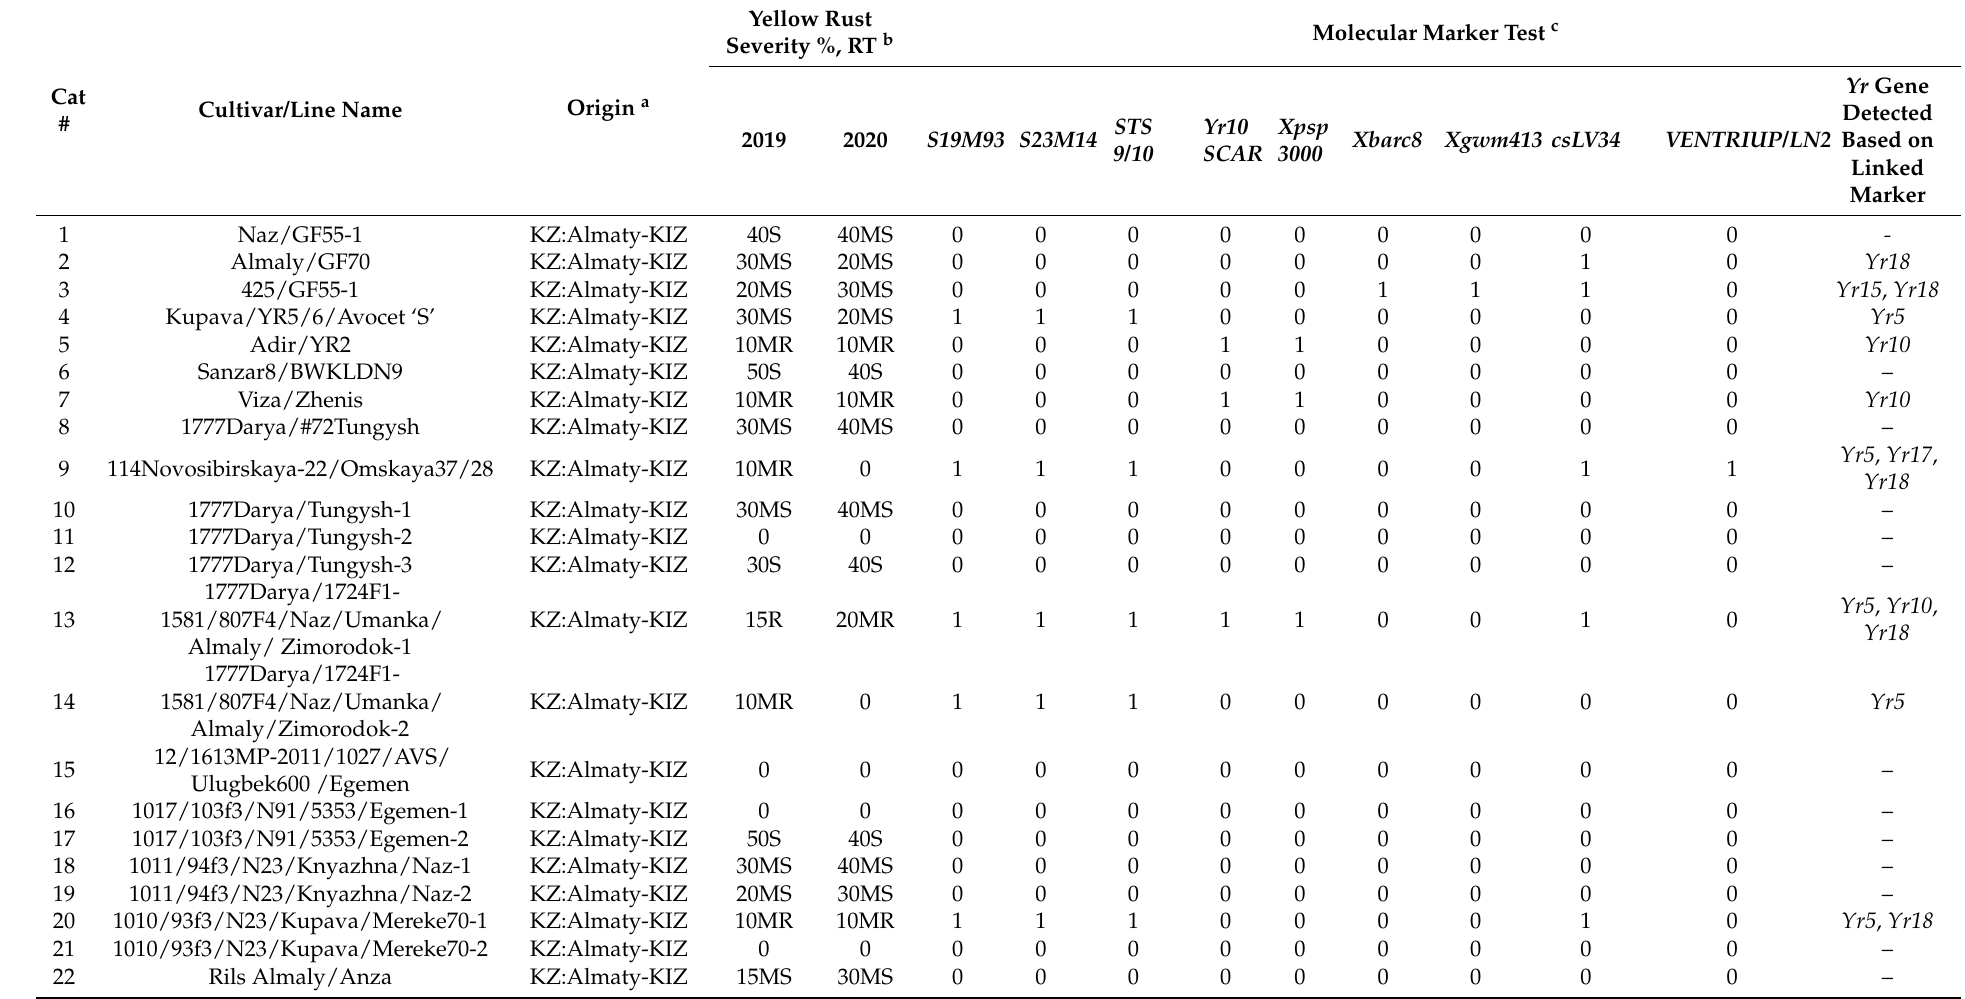
Table 1. Disease severity to stripe rust and presence of Yr genes in wheat genotypes from